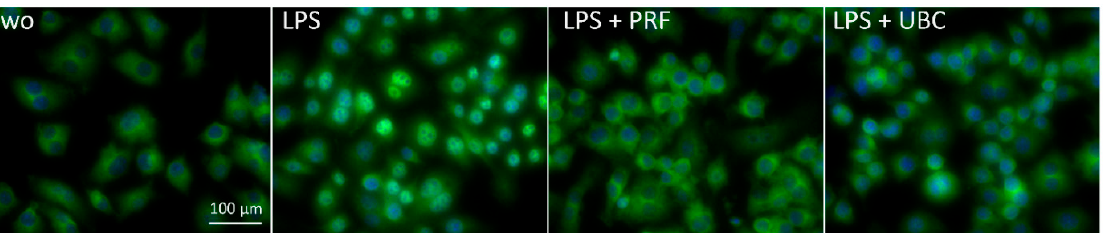
Figure 8. Lysates from PRF and UBC suppress the nuclear translocation of p65 in RAW264.7 cells. RAW264.7 cells were exposed to LPS in the presence or absence of lysates extracted from PRF or UBC. Immunofluorescence analysis of the nuclear translocation of p65 is shown. The blue dots represent nuclei which is hidden by the green dots representing antibody-positive nuclei; “wo” indicates without and represents unstimulated cells. Microscopic magnificence was set at 20×.